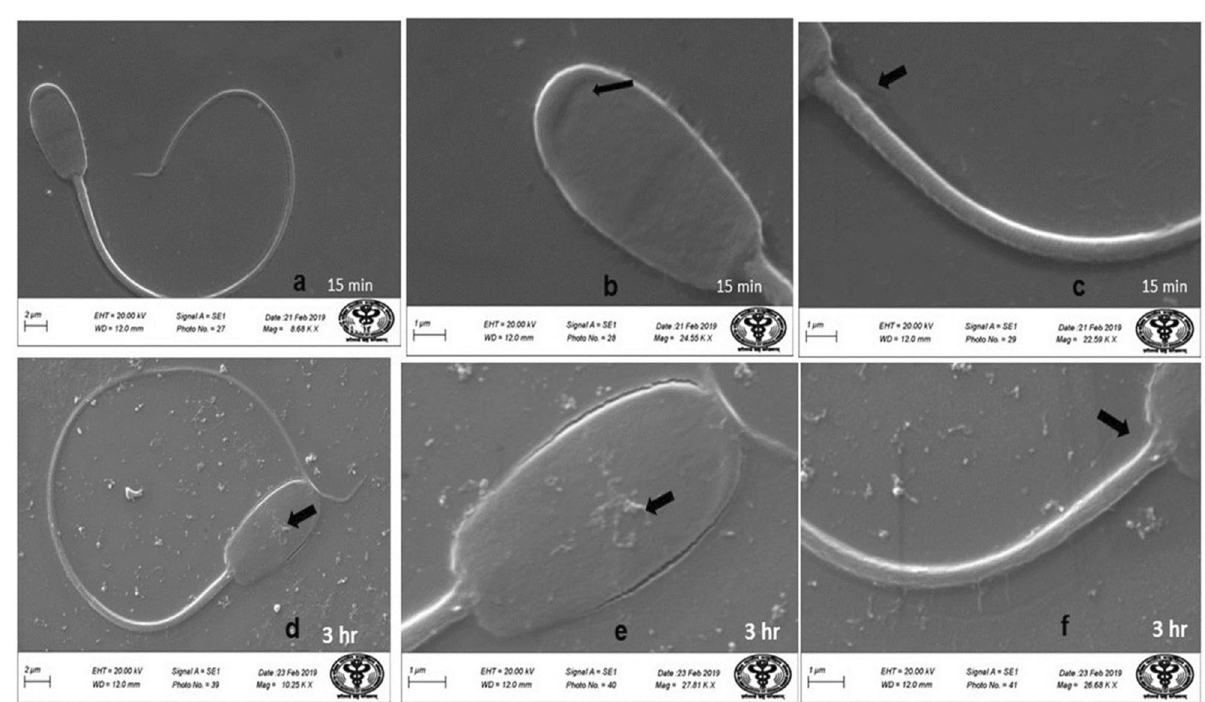
Figure 5. Scanning Electron Microscope images of goat spermatozoa in-vitro treated with Hg (0.031 µg/ ml HgCl 2 ) showing intact head and tail and normal surface morphology ( a ), intact acrosome ( b ) and intact midpiece ( c ) after 15 min exposure. While wrinkled plasma membrane on head region ( d , e ) and middle piece deformities and focal area of membrane rupture at middle piece were more obvious after 3 h exposure of mercury ( f (Fig. 5e,f). In some of the spermatozoa, wrinkled plasma membrane in the head region (Fig. 5e) and focal areas of membrane rupture at the middle piece were observed (Fig. 5f). However, exposure to higher concentration of HgCl 2 (1.25 µg/ml) resulted in deformities in spermatozoa head plasma membrane and middle piece even after 15 min of exposure (Fig. 6a). The SEM analysis also showed that at this time point, 1.25 µg/ml HgCl 2 hampered the head plasma membrane integrity and there were focal points of membrane damage (Fig. 6b). Middle piece of sperm cells harbouring mitochondria also appeared wavy depicting the harmful effects of higher concentration